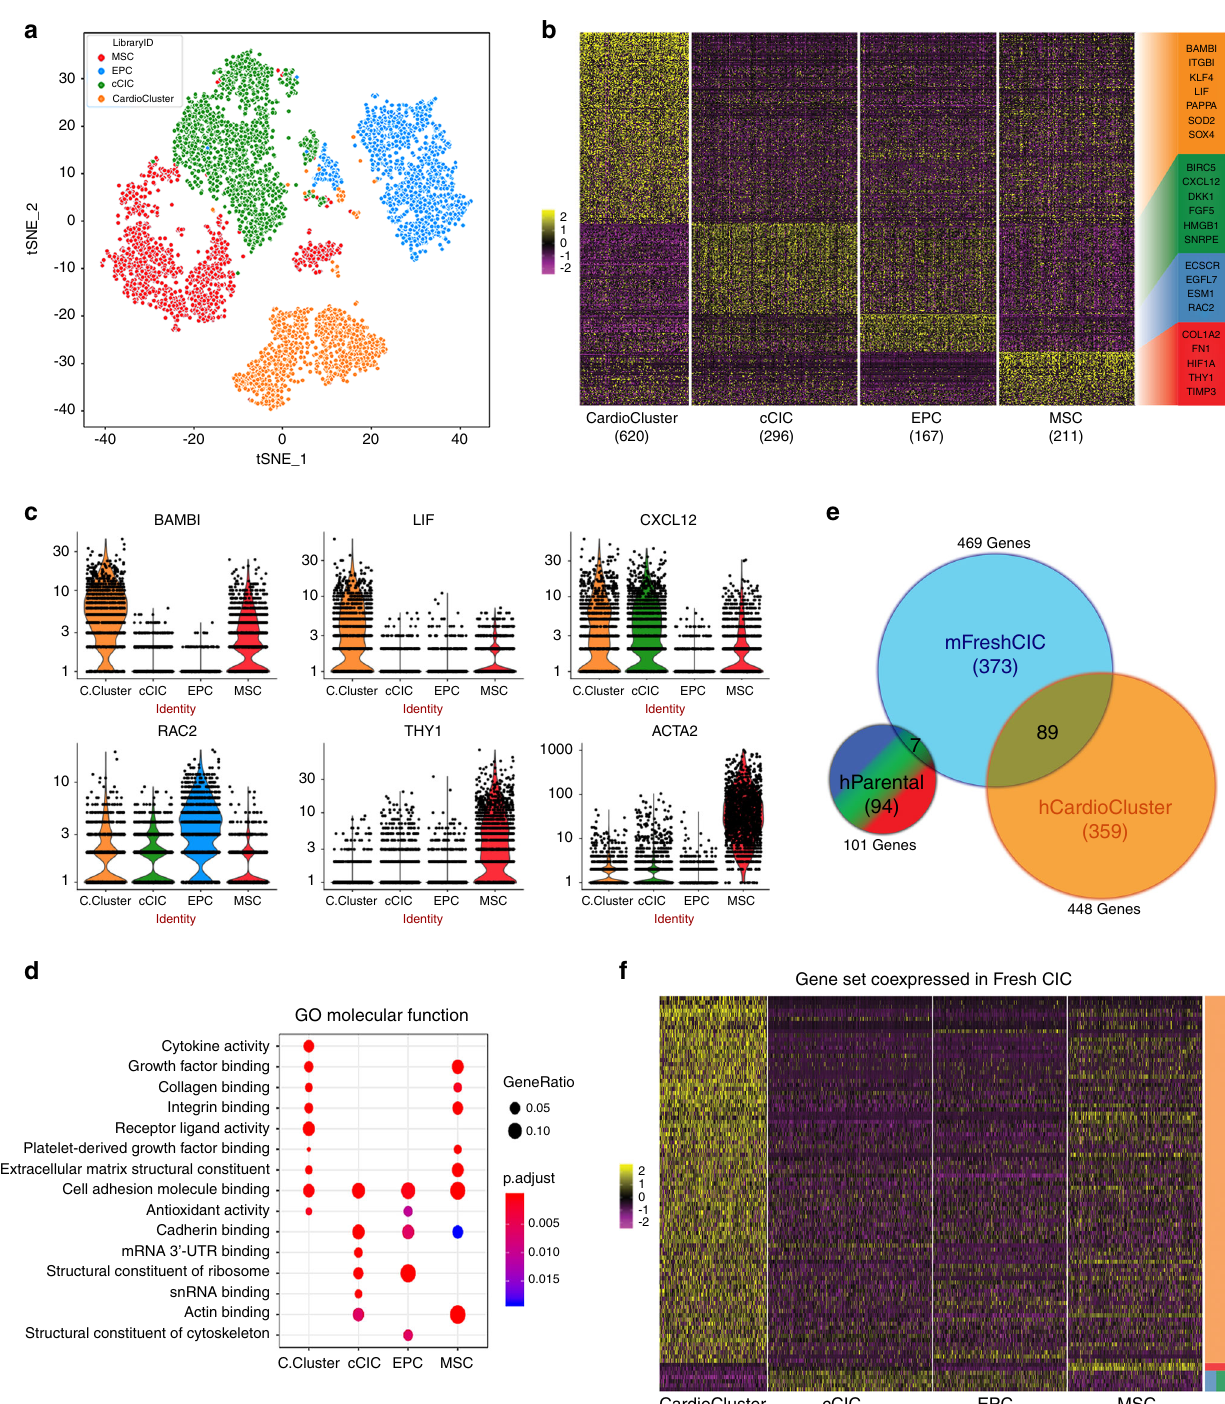
Fig. 9 3D clustering restores cultured cells to a state resembling freshly isolated CICs revealed by single-cell RNA sequencing. a – f Transcriptional pro fi ling on CardioClusters and parental cells using scRNA-seq. a t-SNE map showing cells grown within a 3D CardioCluster (orange) predominately cluster together, while cCICs (green), EPCs (blue), and MSCs (red) primarily cluster into their own individual groups. b Heatmap of differentially expressed genes (DEGs) among CardioClusters and parental cells. Selected DEGs for each group are color-coded and shown on the right. c Violin plots of expression distribution for selected DEGs. d Gene Ontology (GO) term analysis of molecular functions that are enriched based on DEGs. e , f DEGs compared to genes expressed by freshly isolated mouse cardiac interstitial cells (mFreshCIC) represented in a Venn diagram ( e ) and heatmap of the gene set coexpressed by freshly isolated cells in comparison to CardioCluster and parental cell populations ( f ). hParental indicates human parental cells; hCardioCluster, human CardioCluster cells; BAMBI BMP and activin membrane bound inhibitor; LIF leukemia inhibitory factor; CXCL12 C-X-C motif chemokine 12 or stromal cell- derived factor 1 (SDF1); ACTA2 smooth muscle alpha ( α )-2 actin; C. Cluster